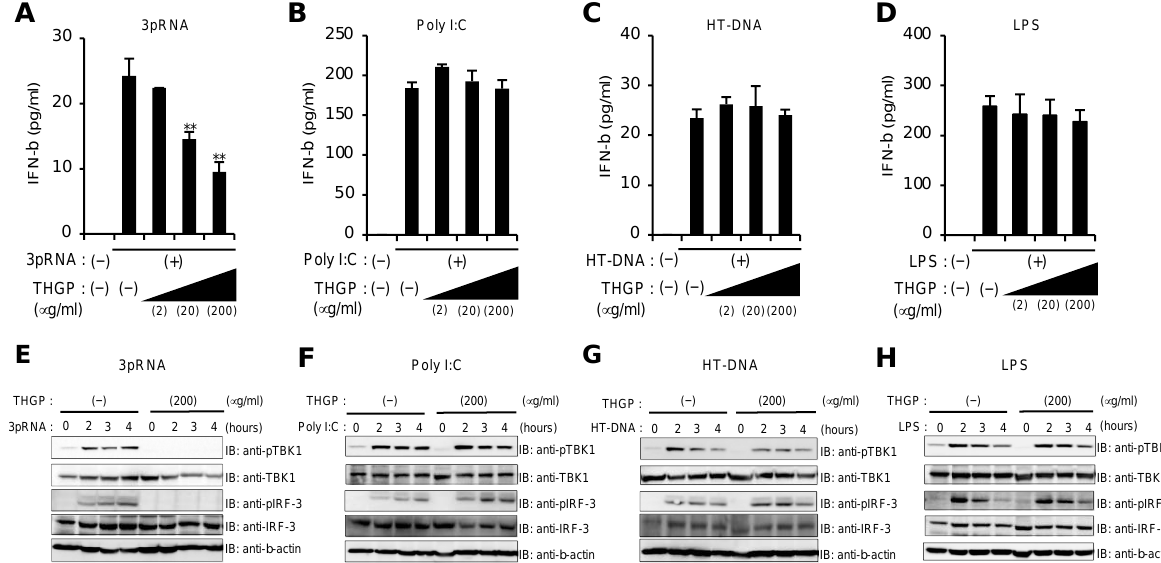
Figure 1. THGP suppresses IFN- β induction in response to 3pRNA but not poly I:C, HT-DNA, and LPS. ( A – D ) ELISA of IFN- β levels at 24 h after stimulation with 3pRNA ( A ), polyI:C ( B ), HT-DNA ( C ), and LPS ( D ) in RAW264.7 cells pretreated with indicated concentrations of THGP for 24 h. Data are presented as mean and s.d. (n = 3). ( E – H ) Whole cell lysates at the indicated time after stimulation with 3pRNA ( E ), polyI:C ( F ), HT-DNA ( G ), and LPS ( H ) in RAW264.7 cells pretreated with THGP for 24 h, which were prepared and subjected to immunoblotting with anti-pTBK1, TBK1, pIRF-3, IRF-3, and β -actin antibodies. ** p < 0.01 vs. control. Data are representative of at least three independent experiments.